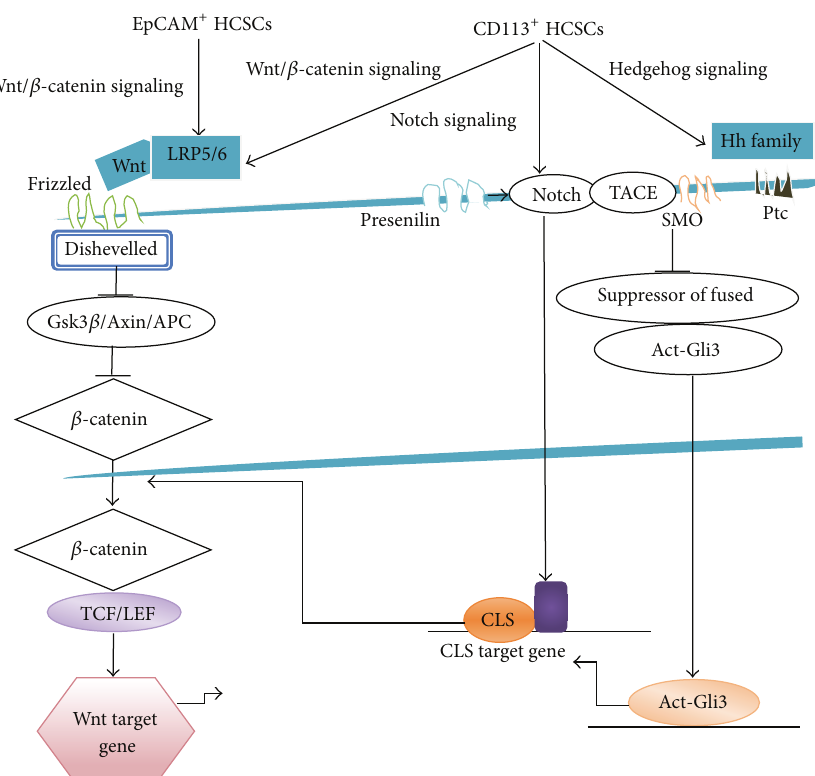
Figure 1: Key signaling pathways that regulate the function of hepatic cancer stem cells. The cartoon recapitulates the principle signaling pathwaysthatregulatethefunctionofhepaticCSCssuchasWnt/ 𝛽 -catenin,Hedgehog,andNotch.Epithelialcelladhesionmolecule(EpCAM) is a Wnt/ 𝛽 -catenin signaling target gene. The activation of Wnt/ 𝛽 -catenin signaling regulates EpCAM expression in HCSCs. In CD133 + HCC cells, Wnt/ 𝛽 -catenin, Notch1, and smoothened (SMO)/Hedgehog signaling pathways are associated with proliferation, self-renewal, and differentiation of